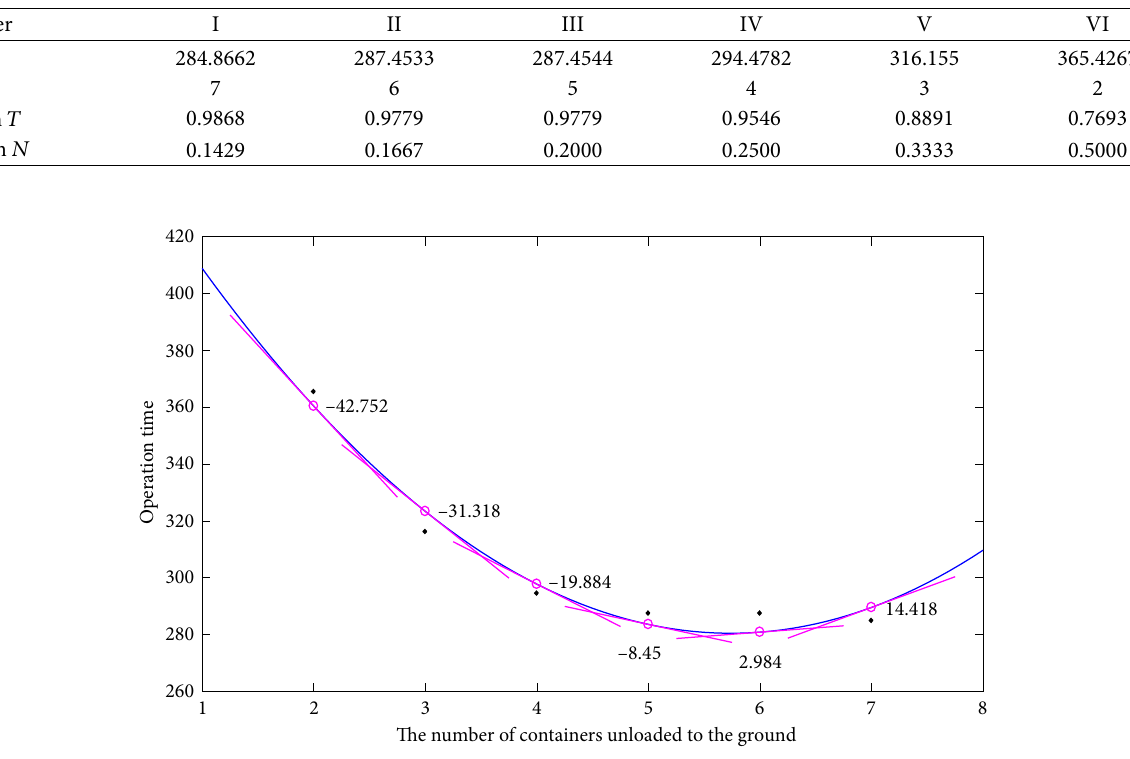
Figure 8: The curve of polynomial fitting.